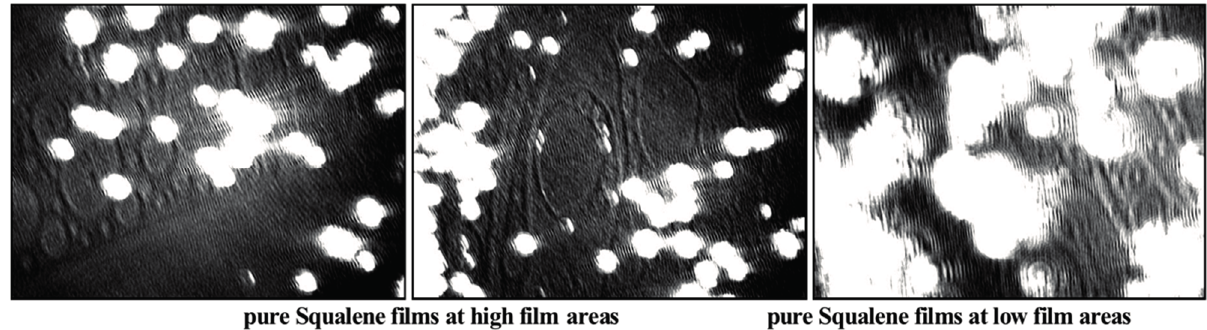
Figure 5. Characteristic UltraBAM images (720 µm × 400 µm) of squalene layers, which shows irregular and partial spreading of squalene with lens formation already at high film areas; at compression, the lenses aggregate and get